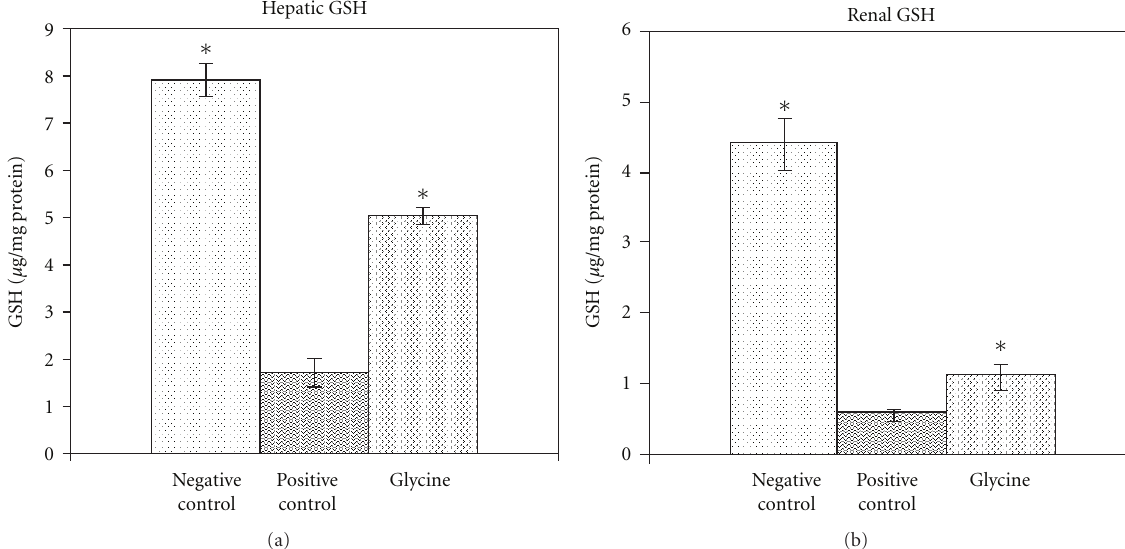
Figure 1: Therapeutic e ffi cacy of glycine (100mg/kg) on GSH levels in the liver and kidney of lead-exposed rats. Values are mean ± SE; n = 5. ∗ P < 0 . 05 compared with positive lead control.